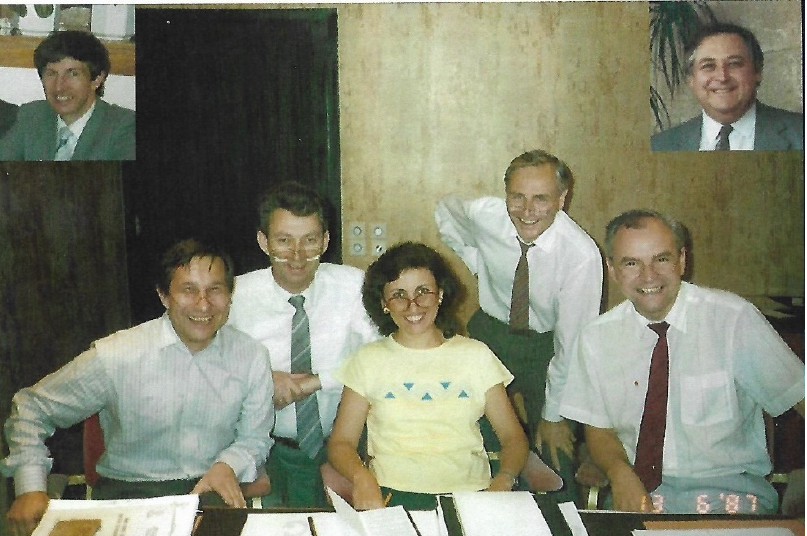
Figure 3. The CSE steering committee pictured in 1987 laughing at each other wearing glasses. The picture was taken by PWM. From left to right: (inset) Peter Macfarlane (1987); Christoph Zywietz; Jan van Bemmel; Rosanna Degani; Pierre Arnaud; Jos Willems; (inset) Paul Rubel (1992), who took over from Pierre Arnaud.